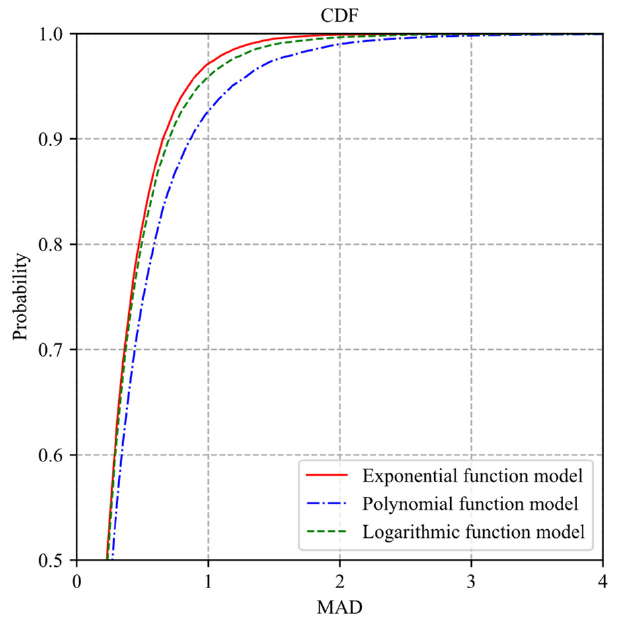
Figure 4. CDF curves of MADs of prediction distortion vectors predicted by three distortion models. The MAD of an image is the average MAD of all image blocks according to Equation